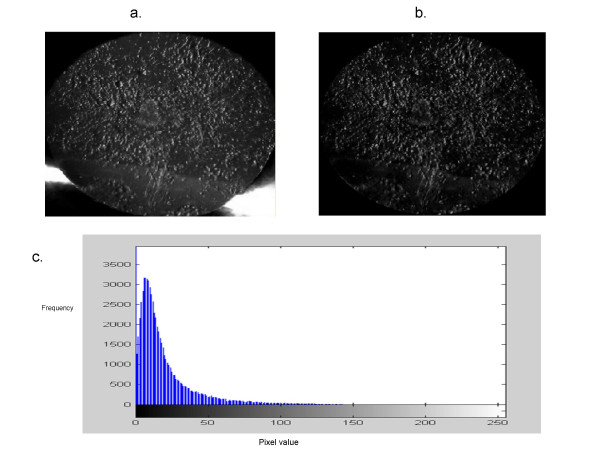
a. Original greyscale image, b. background removed, c. image histogram